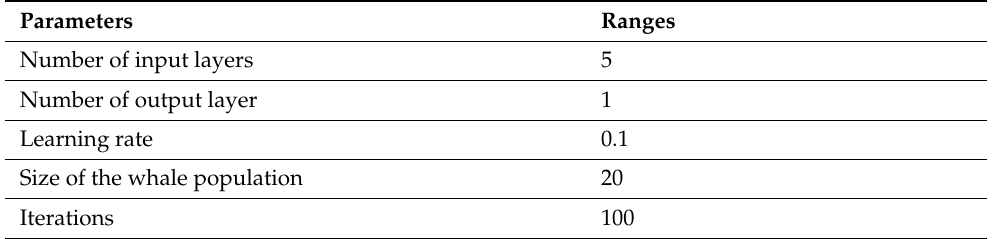
Table 2. Simulation